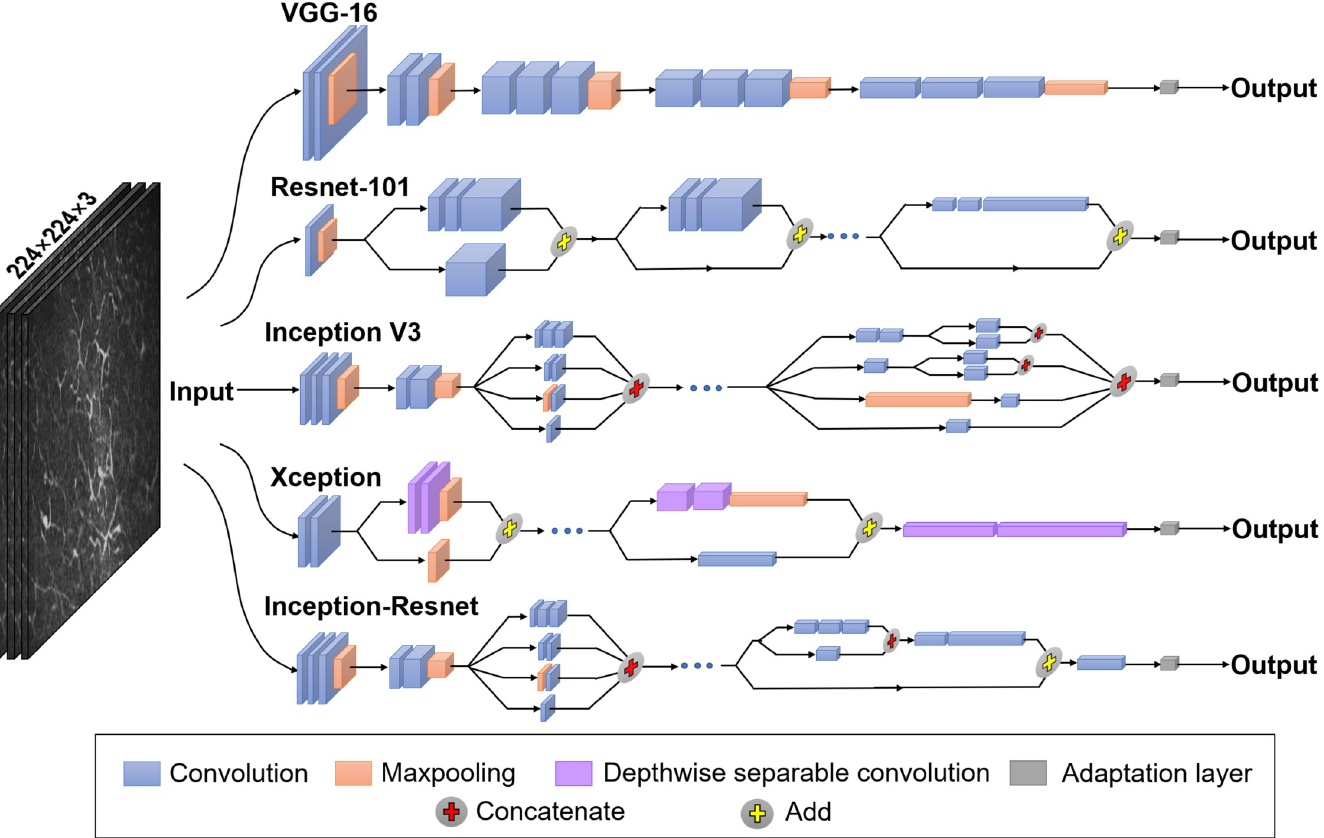
Fig 2. An overview of the five pre-trained networks architectures used in this study. The networks take images of 224 × 224 pixels as input and process the images through layers of nonlinear operations such as convolution and pooling. The arrows indicate the direction of flow. All convolution layers of the VGG-16 networks are depicted, but the intermediate repetitive layers of the other networks are omitted for simplicity. The final fully-connected layer was removed, replaced by an adaption layer.